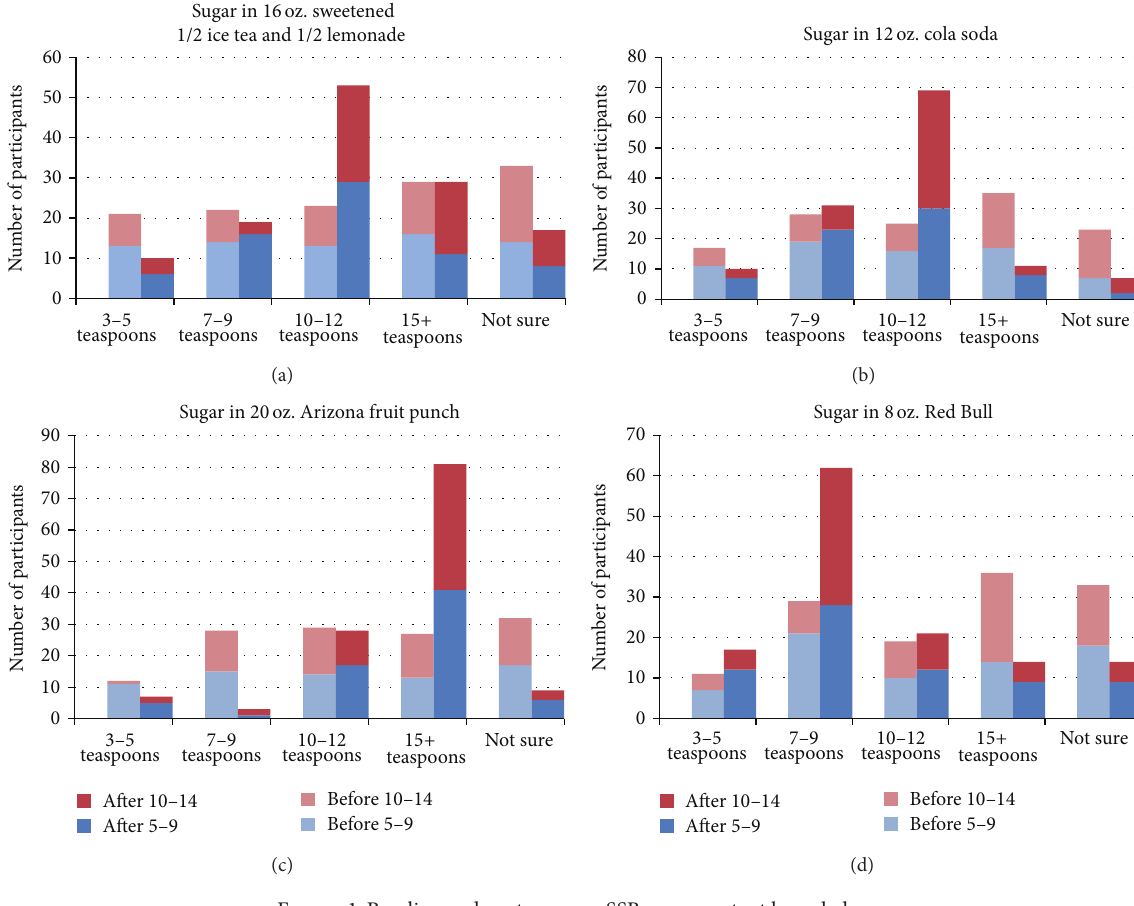
Figure 1: Baseline and postprogram SSB sugar content